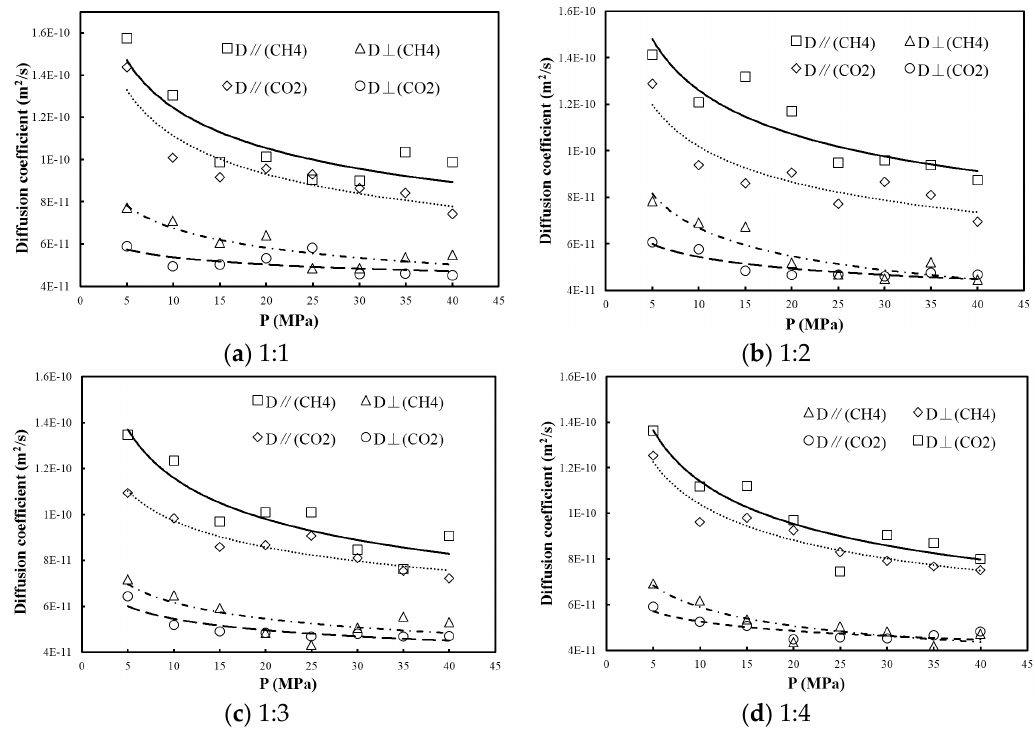
Figure 6. Self-diffusion coefficient of CH 4 /CO 2 mixture in different directions.